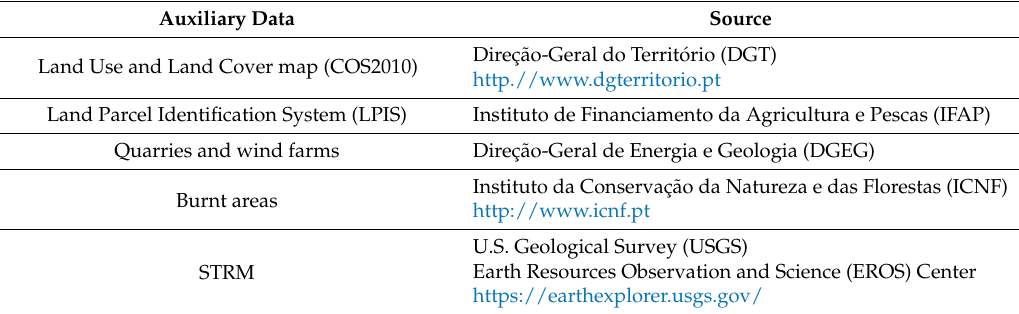
Table 3. Auxiliary data used in supervised and rule-based image